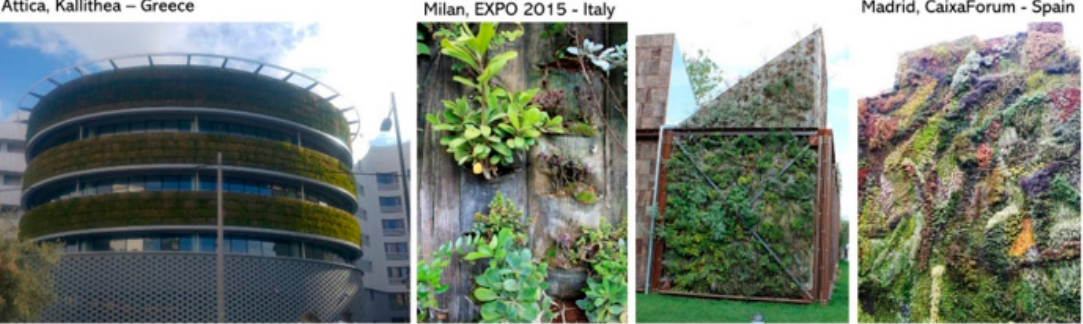
Figure 2. Examples of green walls in Figure 2. E xamples of green walls in Europe.